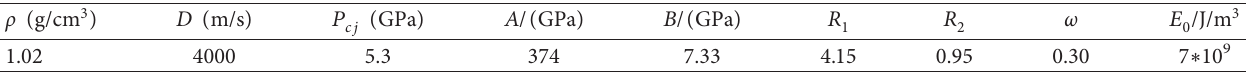
Figure 2: Numerical simulation model of the vertical shaft wall. (a) Schematic diagram of the model. (b) Front view of the model. (c) Top view of the model. (d) Meshing of the model. Table 1: Parameters used in the explosive materials and state